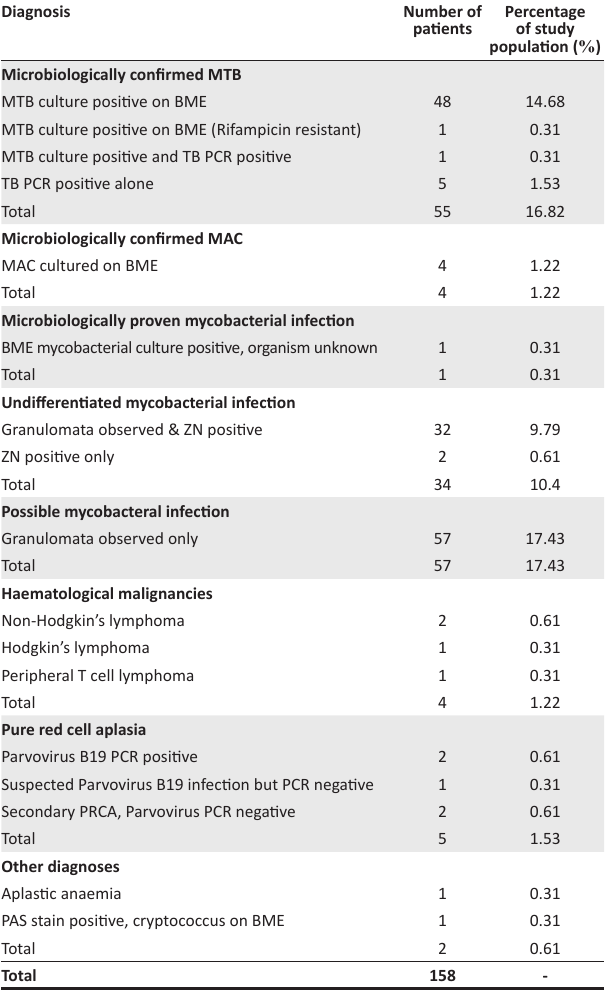
TABLE 1: All diagnoses on bone marrow examination. Diagnosis